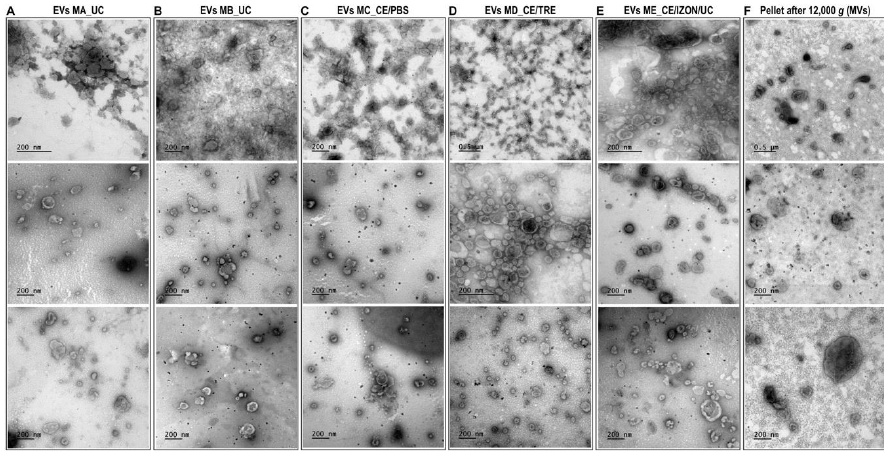
Figure 2. Representative images of extracellular vesicles (EVs) and microvesicles (MVs) isolated by different methods obtained by transmission electron microscopy observations. ( A ) EVs obtained by Method A, ultracentrifugation (UC) 100,000 × g (2 × ) 90 min using fixed angle Beckman rotor (MLA-55) and Beckman bottles (No. 355603); ( B ) EVs obtained by Method B, UC with swing-out rotor MLS-50; ( C ) EVs obtained by Method C, ultrafiltration using Centricon filters (CE) followed by a washing step with PBS and then UC; ( D ) EVs obtained by Method D, similar to C but washing step with PBS/25 mM trehalose; ( E ) EVs obtained by Method E, a combination of CE, followed by size exclusion chromatography (Izon qEV columns) and concentration of EVs fractions by UC; and ( F ) Microvesicles obtained from the pellet after centrifugation at 12,000 × g for 30 min. Int. J. Mol. Sci. 2021 , 22 , x FOR PEER REVIEW